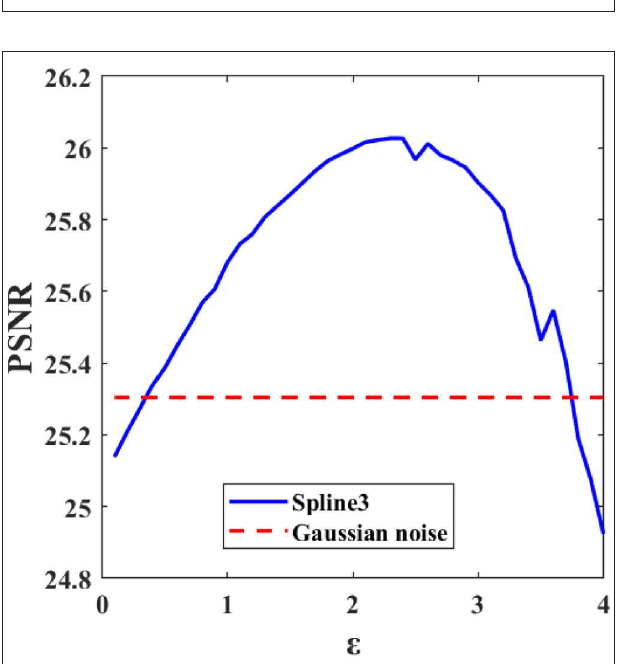
FIGURE 15 | PSNR value obtained by spline inpainting with order 3 and different parameters ε . The PSNR of the Gaussian noisy image is plotted as